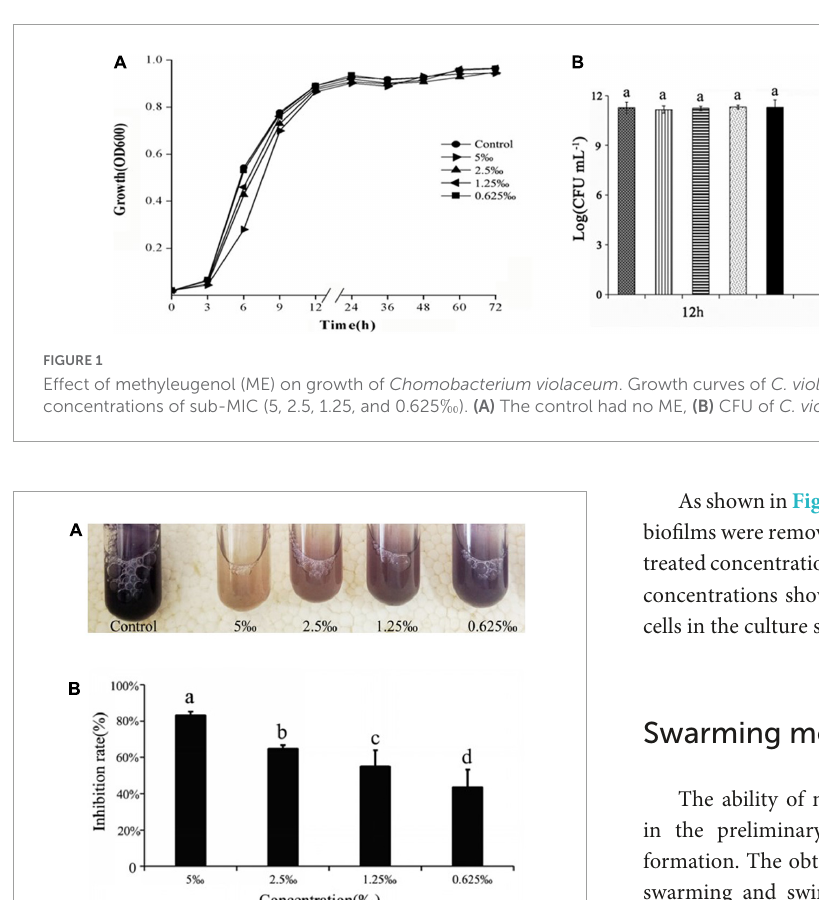
FIGURE2 Quorum sensing (QS) inhibitory activity of ME against violacein production in Chomobacterium violaceum ATCC31532. (A) Effect of methyleugenol (ME) on violacein production in C. violaceum . ME-treated cultures showing progressive reduction at the concentration of sub-MIC (5, 2.5, 1.25, and 0.625 ). (B) Quantitative analysis of violacein inhibition rate in C. violaceum by ME. Mean values of triplicate (cid:104)